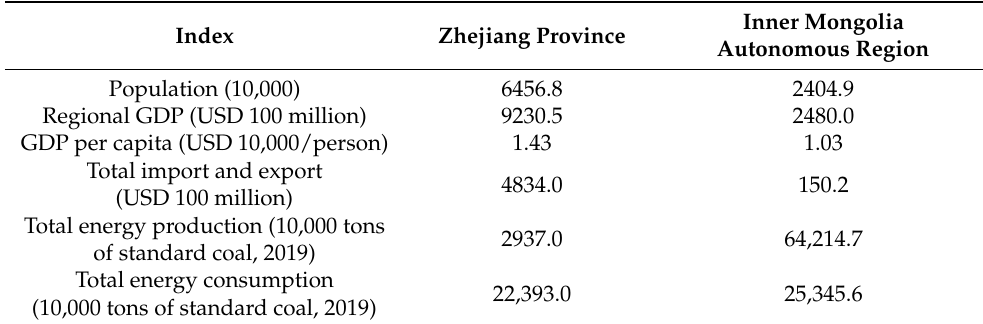
Table 1. Comparison of basic data between Zhejiang Province and Inner Mongolia Autonomous Region in